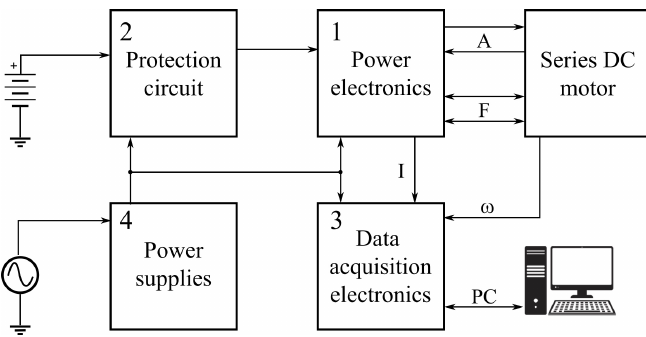
Figure 9. Power driver general scheme.